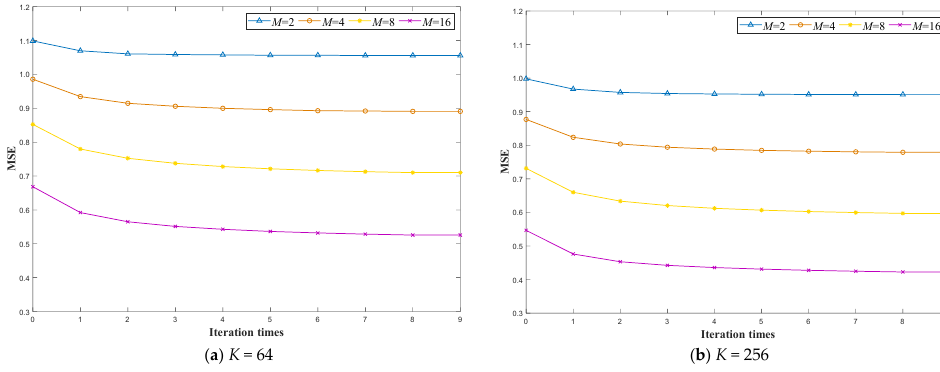
Figure 4. The convergence of training codebooks on GIST-1M. Figure 3. The convergence of training codebooks on SIFT-1M.